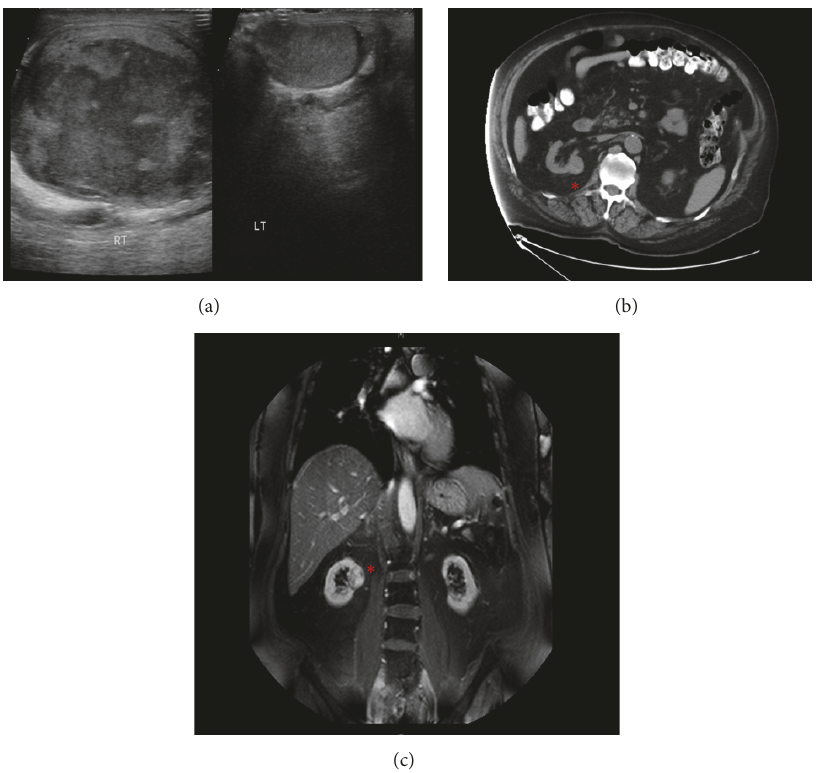
Figure 1: (a) Sonogram of both testes: sagittal view showing grossly enlarged right testis in comparison with the left. (b) T2-weighted MRI of the abdomen with contrast, transverse, and (c) sagittal views; renal cell carcinoma (red asterisk) noted on the right native